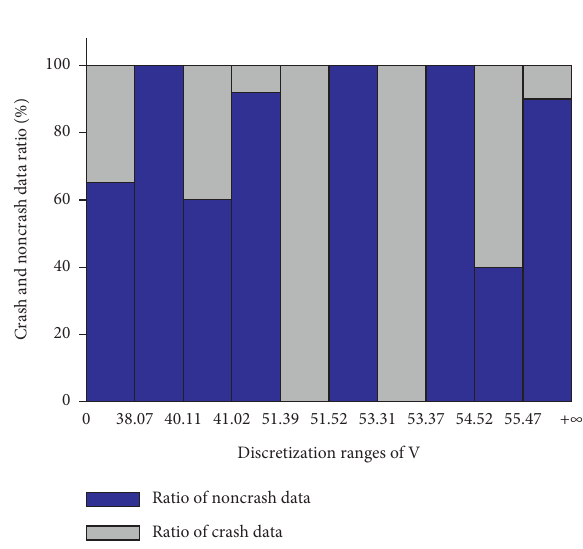
Figure 4: Discretization ranges of